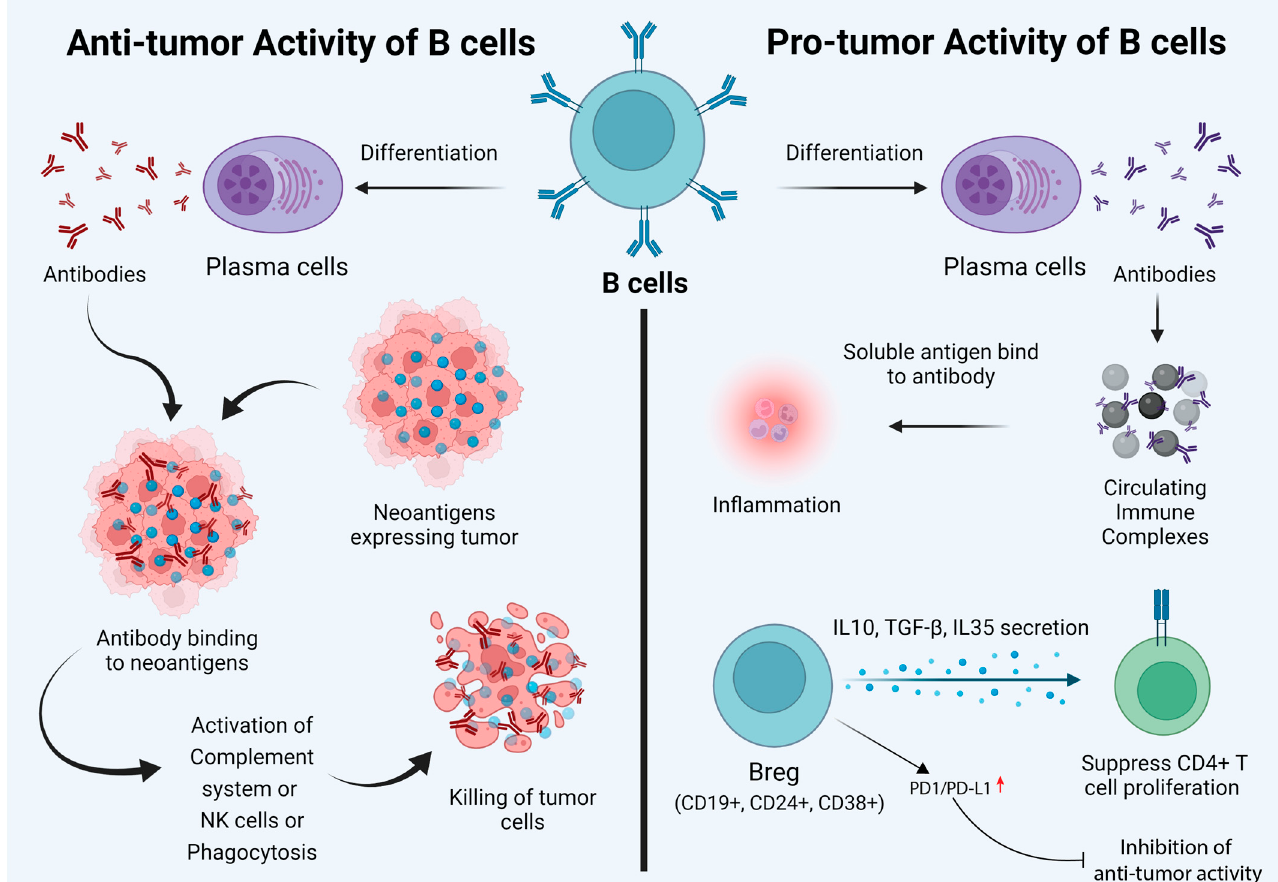
Figure 1. Dual nature of B cells in the cancer tumor microenvironment. Their anti-tumor character- istics can be utilized to empower immunotherapy goals. While behaving as anti-tumorigenic (left panel), B cells can recognize tumor-specific “neoantigens” and can stimulate antibody production, thus killing oncogenic cells. B cells can also have a pro-tumorigenic effect and promote tumor growth. Circulating immune complexes (CICs) and specific types of B cells (e.g., CD19+, CD24+, and CD38+) are the main factors behind this. These Breg cells differentiate due to inflammation and various other factors. They are responsible for immune tolerance and enhance Foxp3 expression in Treg cells. However, in some hepatocellular carcinomas, the expression of PD1/PD-L1 can suppress the anti-tumor activity of Bregs.